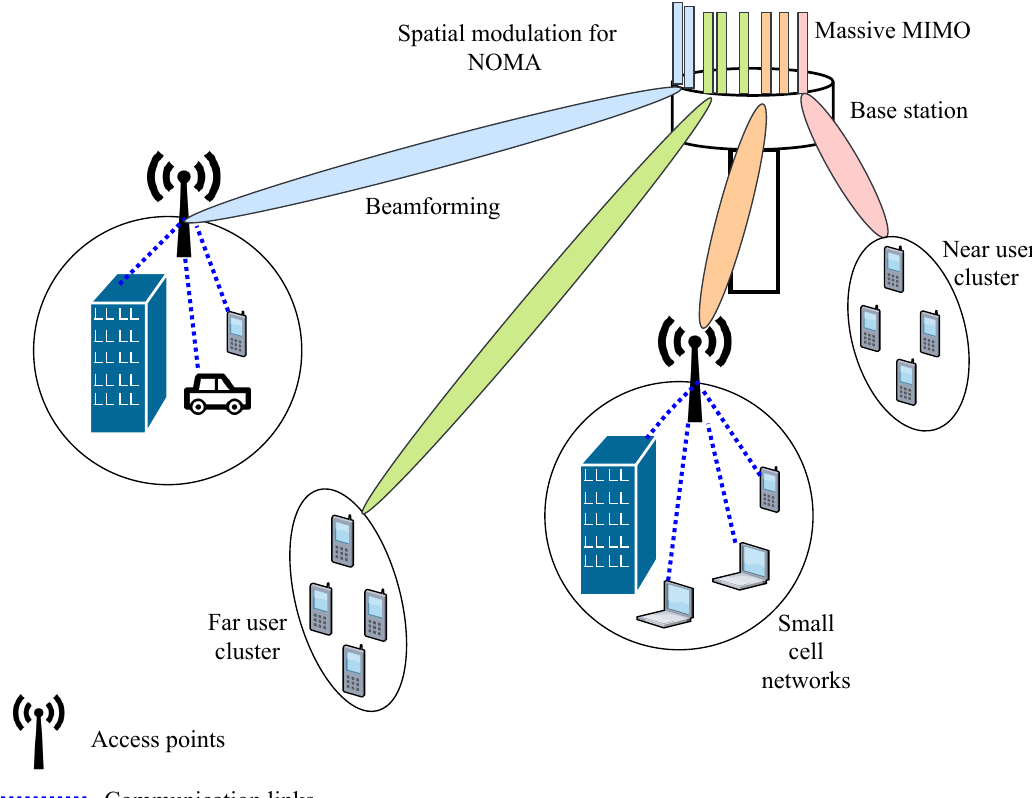
Figure 7. Spatial modulation scheme under NOMA principle, where the spatial diversity of the Massive MIMO BS is utilized to mitigate inter user interference and serve many users